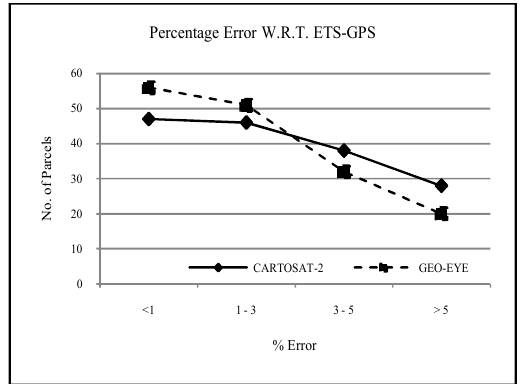
Figure 9. Plot of number of Parcels against the percentage error of area in CARTOSAT-2 and GEO-EYE with respect to ETS-GPS Survey